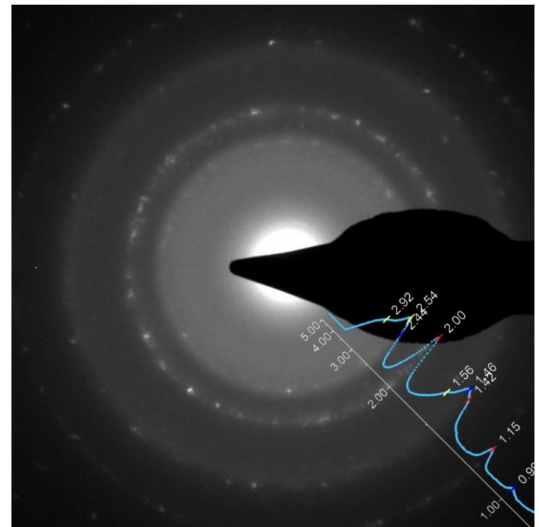
Figure 13. SAD acquired for the Fe 50 Co 50 /TiO x as-prepared sample. The overlaid blue plot is the profile analysis of the SAD obtained by azimuthal integration of the underlying image. The profile was computed by using the plugin PASAD [38] for the software Digital Micrograph from Gatan. The x-axis represents the interplanar spacing in Å. The position of Bragg reflections are indicated by the vertical colored bars and are labeled with the corresponding d -spacing. TiO 1- δ , α -Fe-Co alloy, and cobalt ferrite (blue, red and yellow vertical bars respectively) are